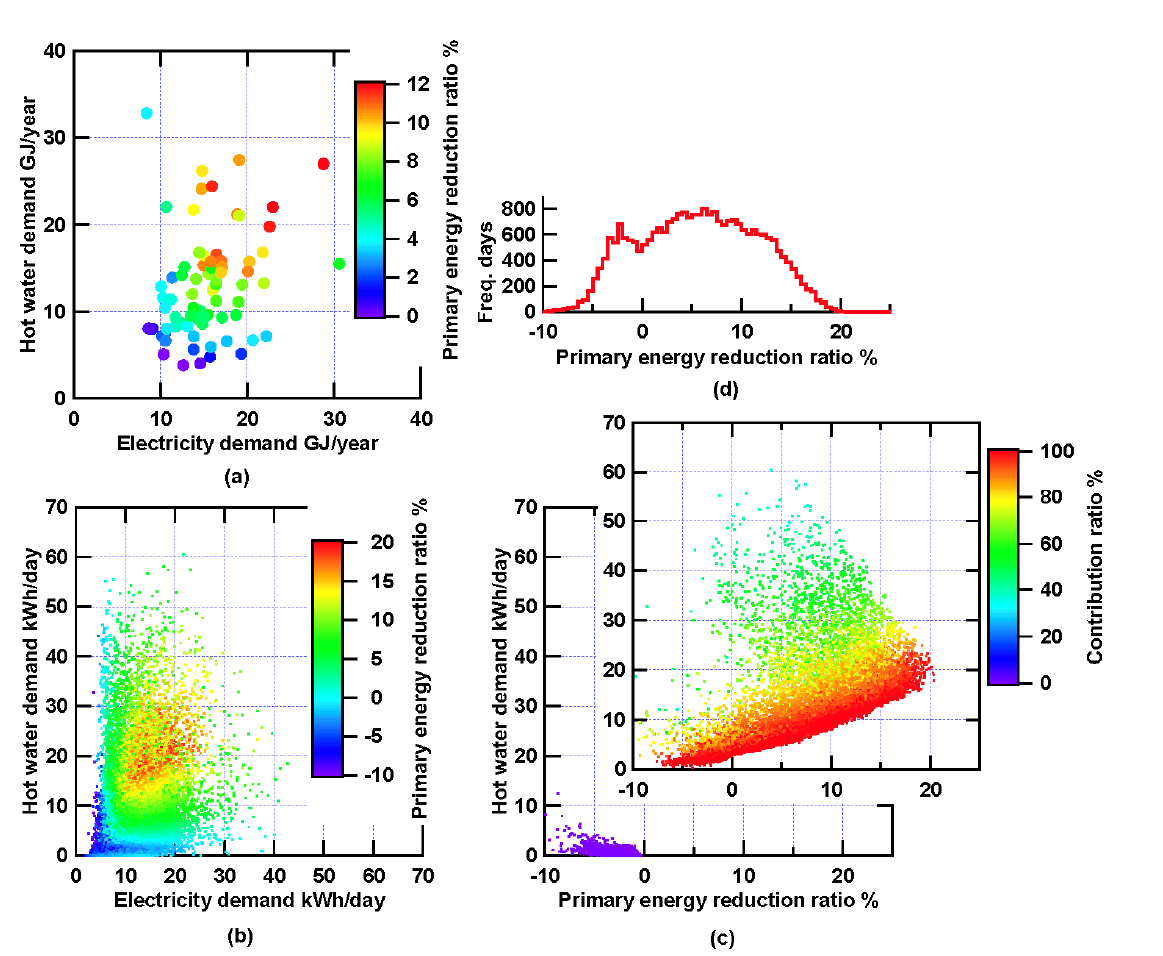
Figure 7. Distribution of primary energy reduction ratio in optimal operation. ( a ) annual; ( b ) daily; ( c ) DHW demand vs. daily primary reduction ratio with contribution ratio; ( d ) frequency of primary energy reduction